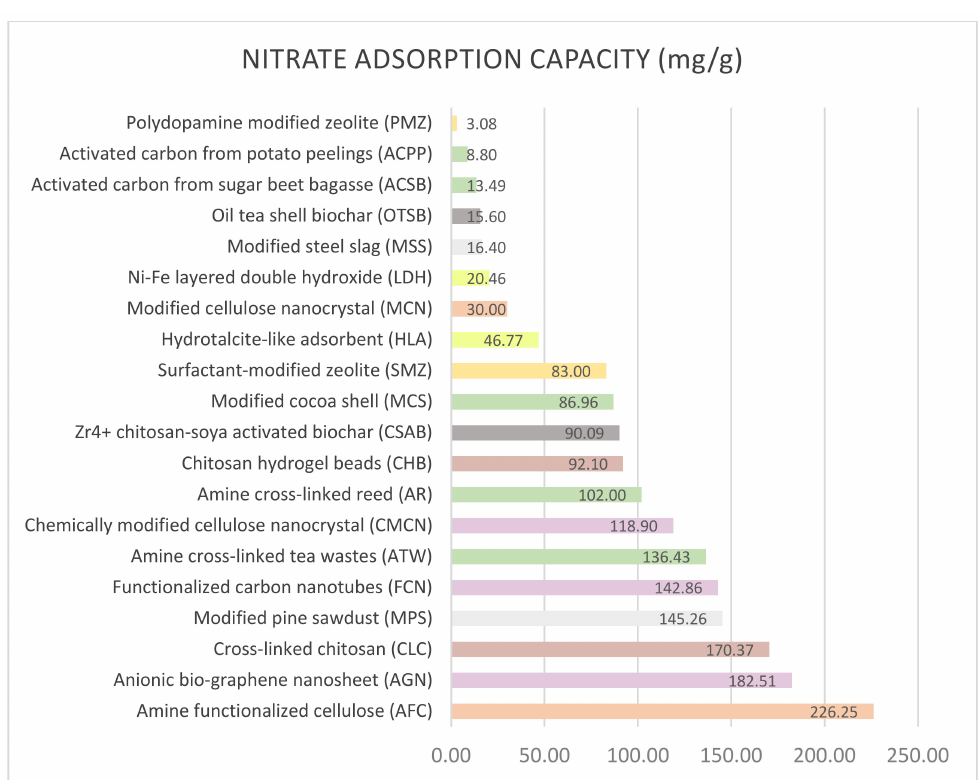
Figure 5. Nitrate adsorption capacities of selected sorbents. PMZ [125], ACPP [126], ACSB